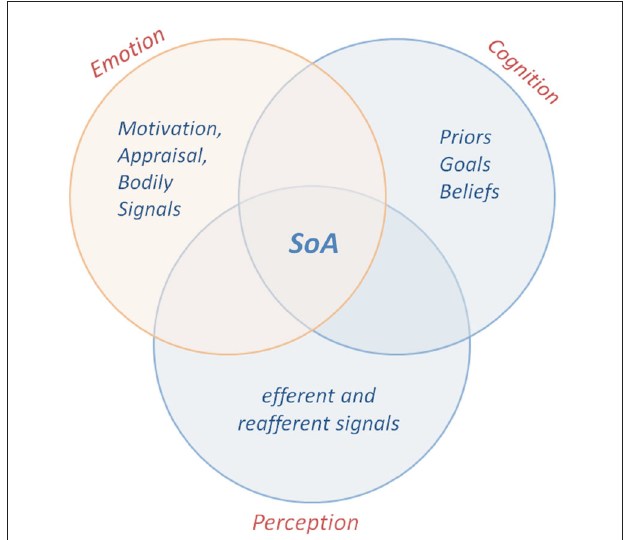
FIGURE 1 | Illustration of the integration of the affective dimension in cognitive-sensorimotor mechanisms underlying agentive awareness . The contribution of emotional cues in synchrony with sensorimotor and cognitive cues in the formation of sense of agency (SoA) is displayed.